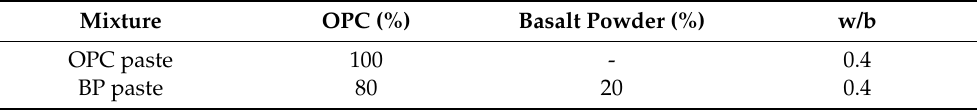
Figure 3. Morphology of OPC ( a , b ) and BP ( c , d ). Table 2. Mix proportions of